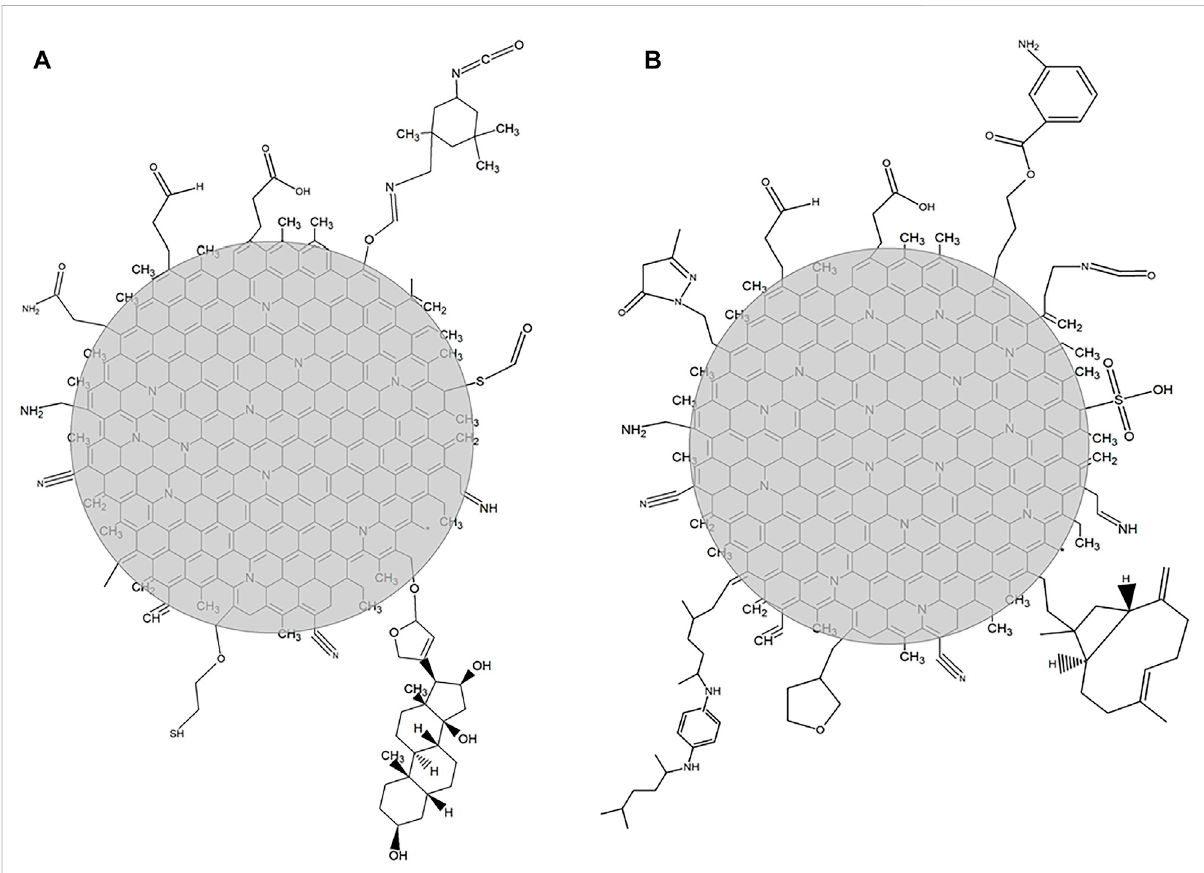
FIGURE 7 Two-dimensional representation of the carbon nucleus and surface of (A) CQD a and (B) CQD b